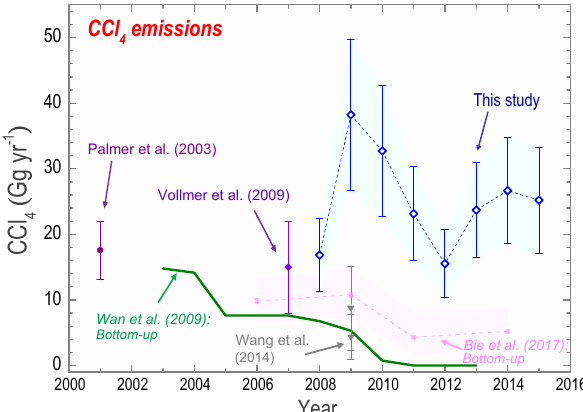
Figure 3. CCl 4 emissions in China as determined by an interspecies correlation method. A comparison between our results and previous estimates for Chinese emissions is also shown. Note that emissions reached a maximum in 2009–2010 in concurrence with the sched- uled phase-out of CCl 4 by 2010, but the average annual emission rate of 23 . 6 ± 7 . 1Ggyr − 1 for the years 2011–2015 is still substan-